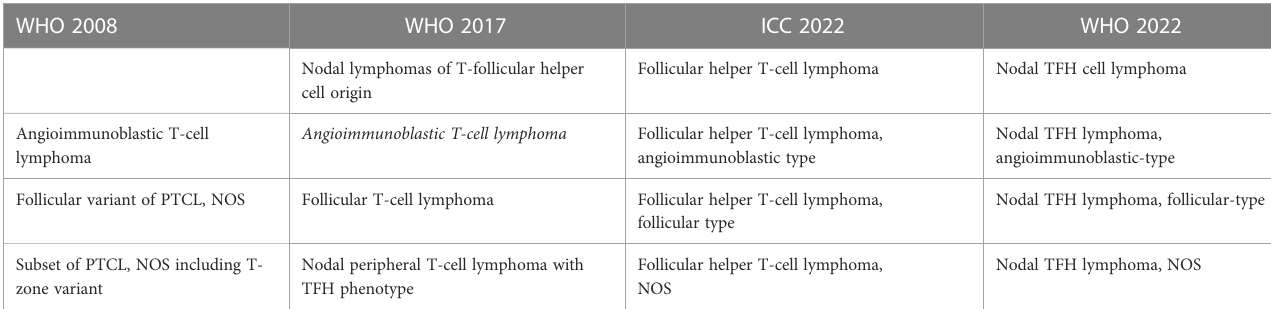
TABLE 1 Different designations for nodal T cell lymphomas with a TFH immunophenotype according to the different classi fi cations schemas. WHO